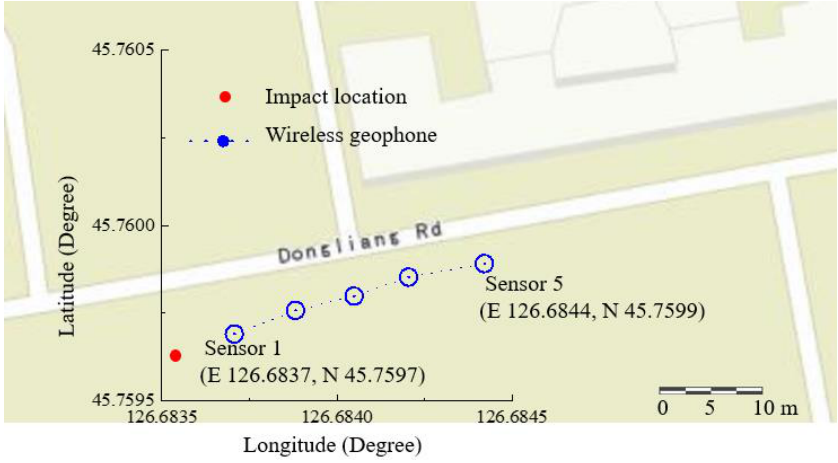
Figure 8. GPS information provided by the satellite-based sensing node.